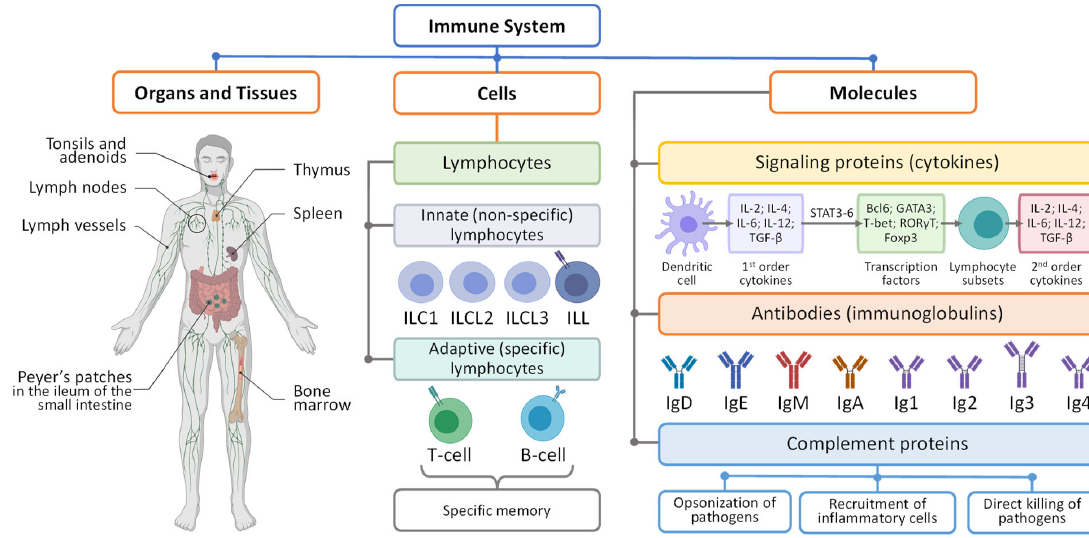
Figure 2. Overview of immune system.